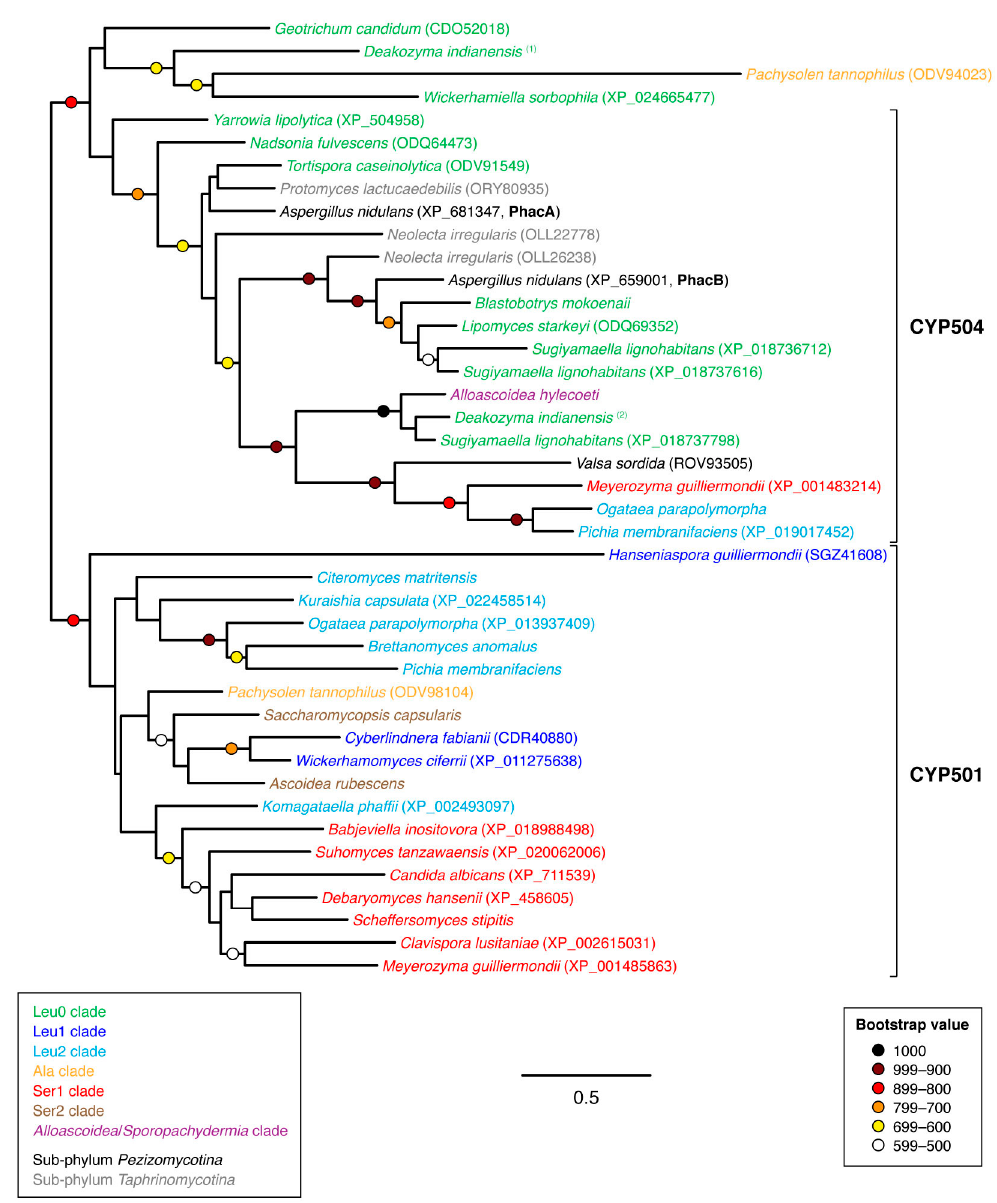
Figure 7. Unrooted phylogram of CYP501 and CYP504 gene products in representative species of sub-phylum Saccharomycotina as well as selected non- Saccharomycotina species. Individual species are color-coded with respect to clade [24]. The analysis was based on 252 aligned amino acid positions of the corresponding proteins. Colored circles represent branch support with the color indicating the proportion of retained nodes among 1000 bootstrap replicates. Branches lacking circles indicate branch support less than 500. Accession numbers for individual protein sequences are displayed when available. Protein sequences lacking accession numbers were derived through conceptual translation of genomic sequences. Named protein sequences are indicated in bold font. (Genomic coordinates for protein sequences derived through conceptual translation of genomic sequences are listed in Table A1 of Appendix A.).